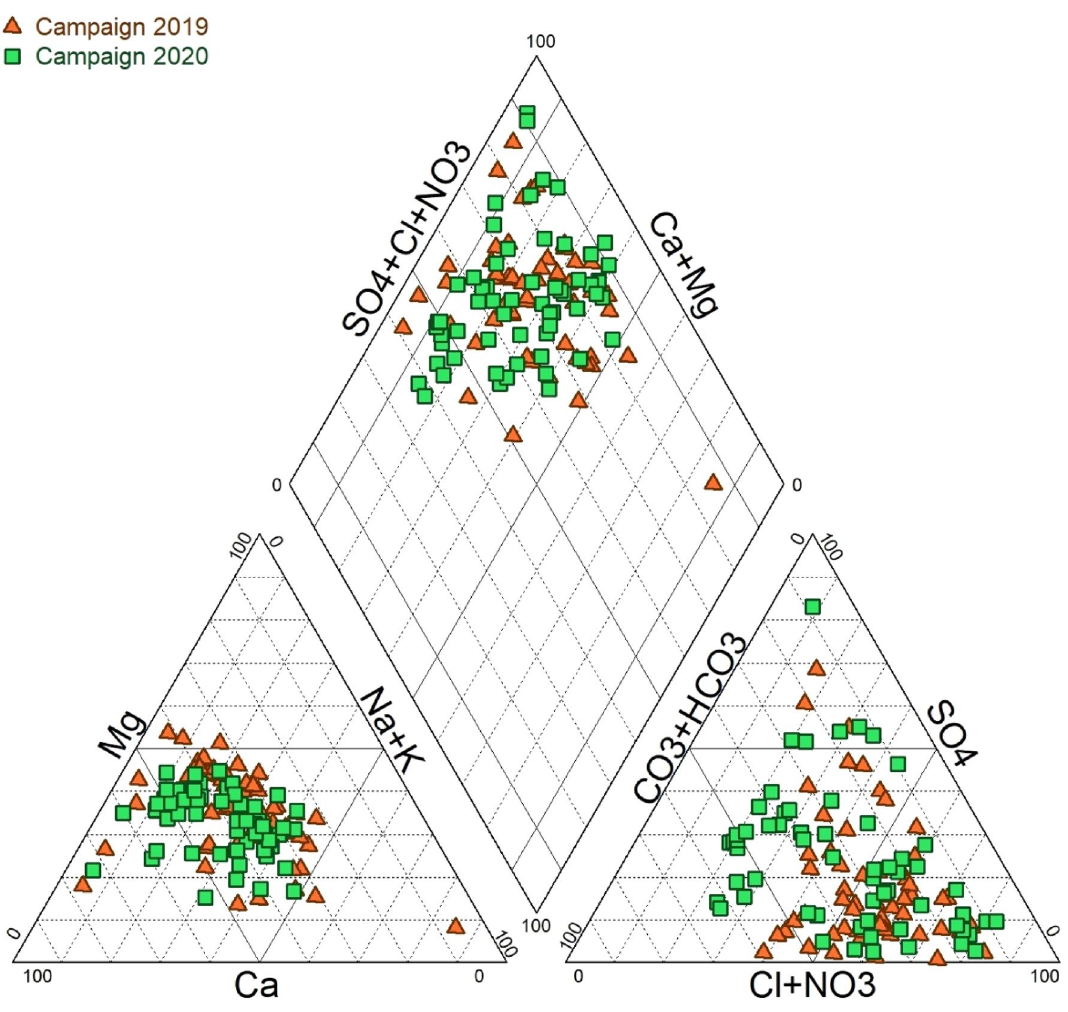
Fig. 3 Piper diagram of groundwater samples in the study